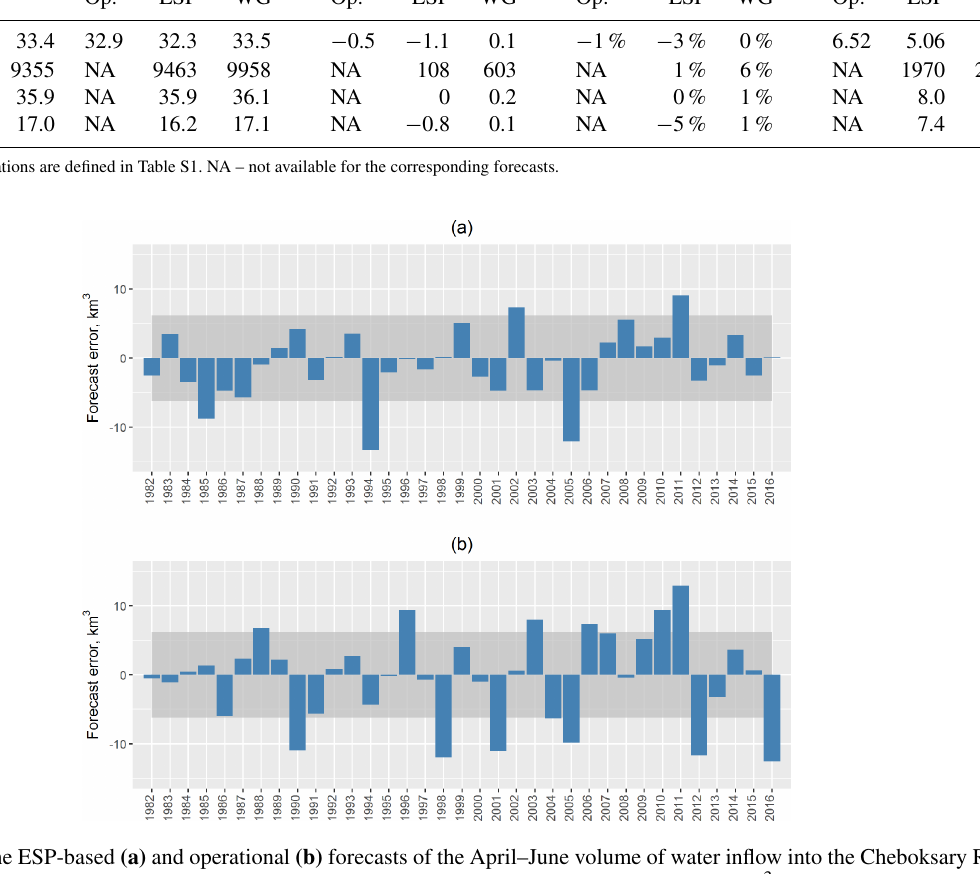
Table 1. Statistics of the operational (Op.) and the ensemble (ESP and WG) deterministic forecasts of inflow into the Cheboksary Reservoir for April–June in 1982–2016. Inflow Obs. Mean Mean error Bias ∗ RMSE characteristics Op. ESP WG Op. ESP WG Op. ESP WG Op. WG